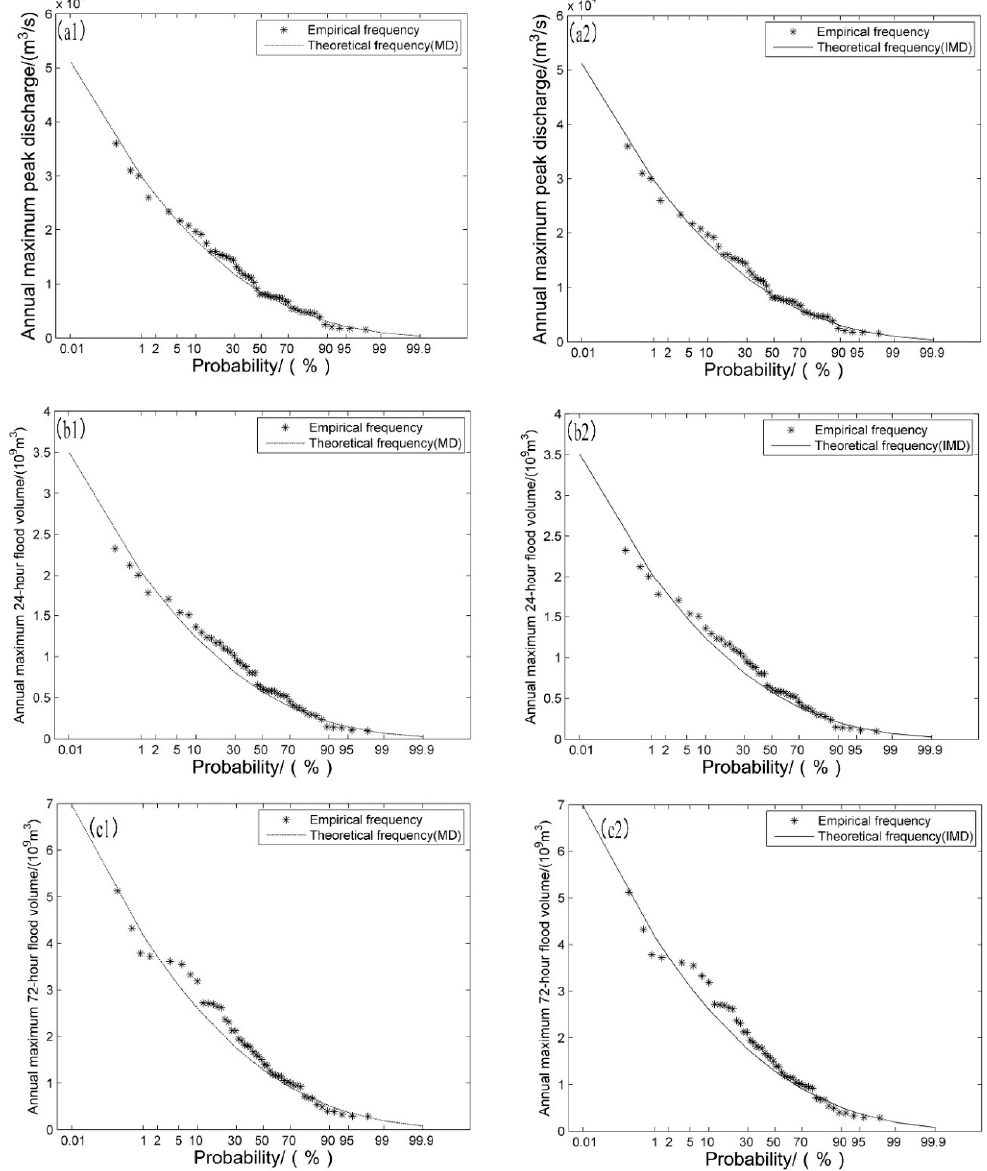
Figure 7. Fitting results of the MD and IMD methods. ( a1 ) MD fitting results of AMPDS; ( a2 ) IMD fitting results of AMPDS; ( b1 ) MD fitting results of annual maximum 24-h flood volume series (24-h AMFVS); ( b2 ) IMD fitting results of 24-h AMFVS; ( c1 ) MD fitting results of 72-h AMFVS; and ( c2 ) IMD fitting results of 72-h AMFVS.